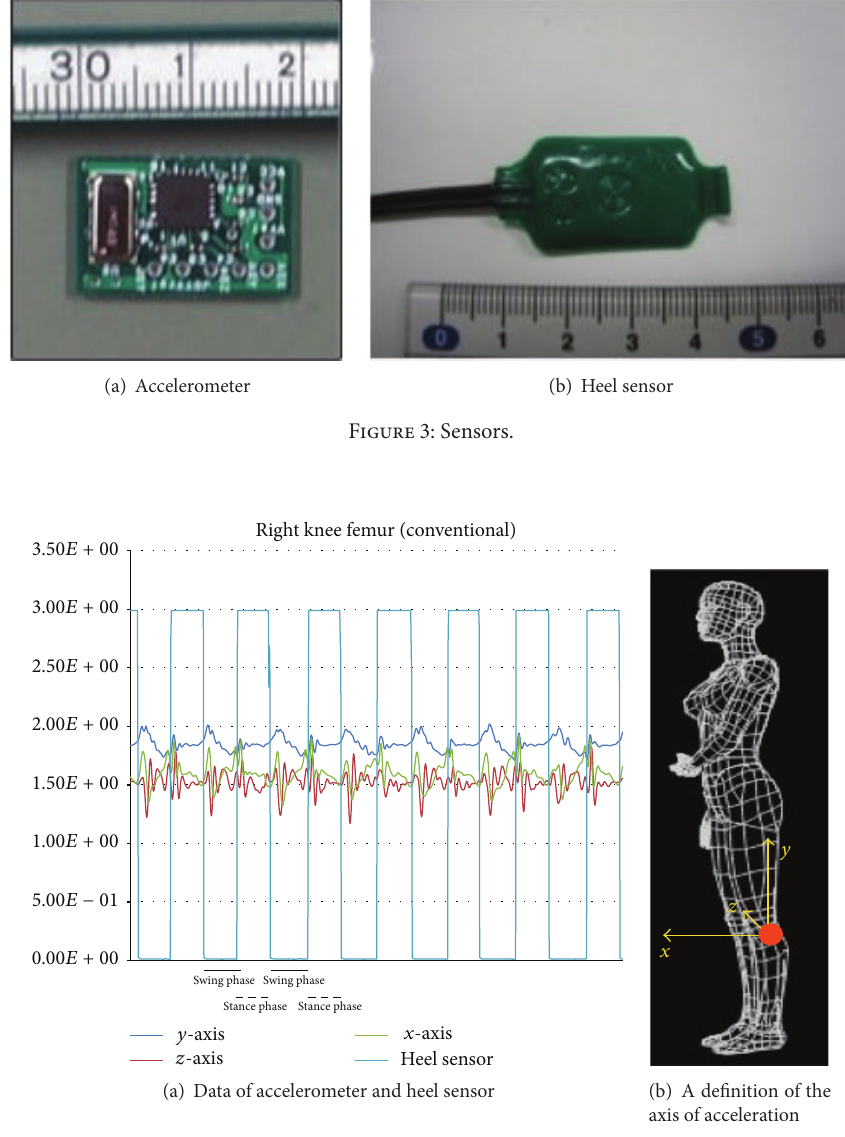
Figure 4: Data of sensors and a definition of the